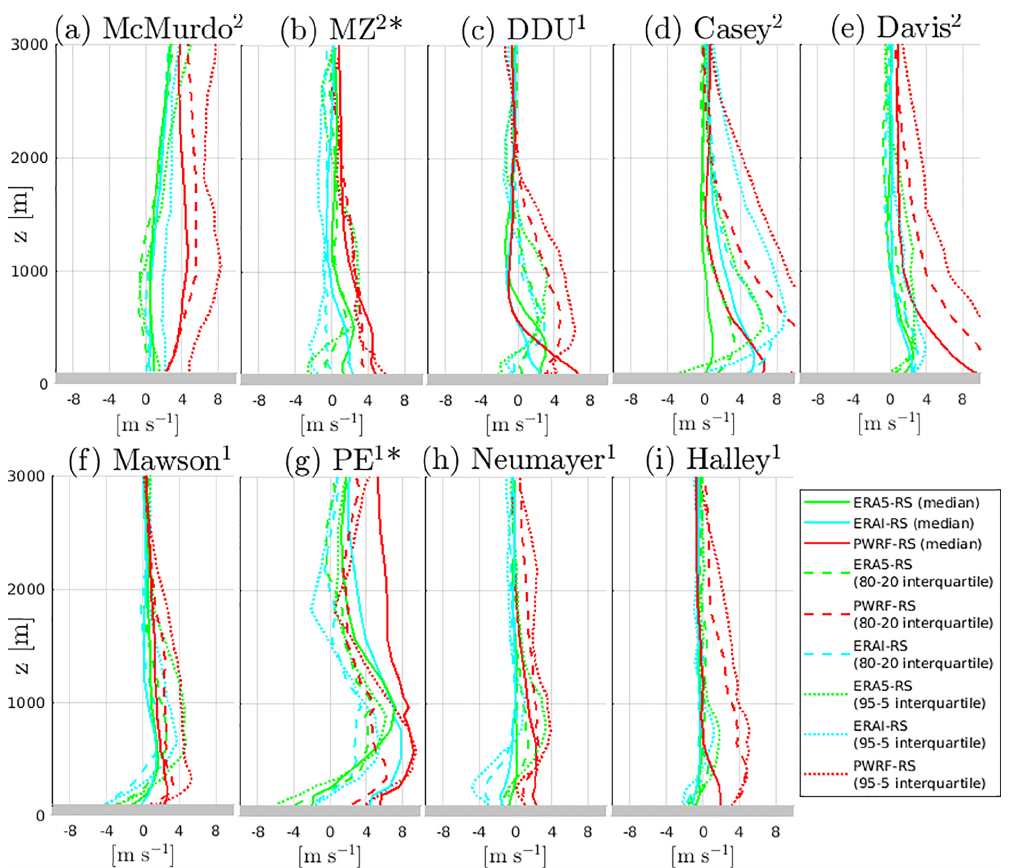
Figure 5. Yearly median differences (solid lines), 80–20th interquartile difference (dashed lines) and 95–5th interquartile difference (dotted lines) with respect to radiosoundings for wind speed at nine Antarctic stations. Red, green and cyan lines refer to Polar WRF, ERA5 and ERA- I, respectively. Grey strips delimit the first 100m above the ground surface. Polar WRF and ERA reanalyses are conditioned to radiosounding times. Numbers in exponential form next to station names in the title indicate the number of radiosoundings per day at the corresponding station. The “ ∗ ” symbol labels the two stations for which only data from December to February are shown. Table 2. Values of the median difference/80–20th interquartile difference/95–5th interquartile difference with respect to radiosonde wind speed data at z = 250m (in ms − 1 ) at four Antarctic stations in katabatic regions. DJF and JJA subsets are